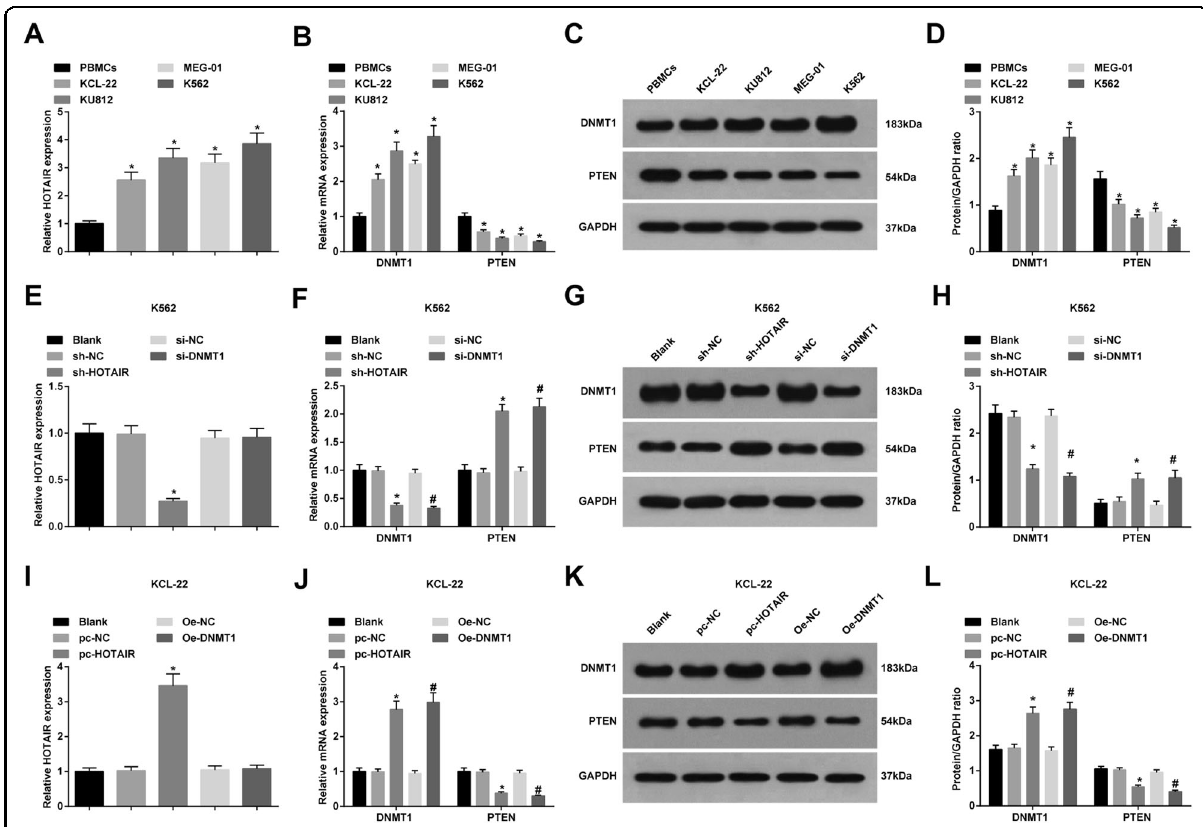
Fig. 2 HOTAIR and DNMT1 expression are elevated, and PTEN is reduced in CML cells. A HOTAIR expression in CML cell lines in each group. B DNMT1 and PTEN mRNA expressions in CML cell lines in each group. C Protein bands of DNMT1 and PTEN in CML cell lines. D DNMT1 and PTEN protein expression in CML cell lines in each group. E HOTAIR expression in each group of K562 cells. F DNMT1 and PTEN mRNA expressions in each group of K562 cells. G Protein bands of DNMT1 and PTEN in each group of K562 cells. H DNMT1 and PTEN protein expression in each group of K562 cells. I HOTAIR expression in each group of KCL-22 cells. J DNMT1 and PTEN mRNA expressions in each group of KCL-22 cells. K Protein bands of DNMT1 and PTEN in each group of KCL-22 cells. L DNMT1 and PTEN protein expression in each group of KCL-22 cells. In CML cell lines, * P < 0.05 vs. the BMCs. In K562 cells, * P < 0.05 vs. the sh-NC group, # P < 0.05 vs. the si-NC group. In KCL-22 cells, * P < 0.05 vs. the pc-NC group, # P < 0.05 vs. the OE- NC group. N = 3. Measurement data were depicted as mean ± standard deviation. Comparisons among multiple groups were assessed by one-way ANOVA followed by Tukey ’ s multiple comparisons